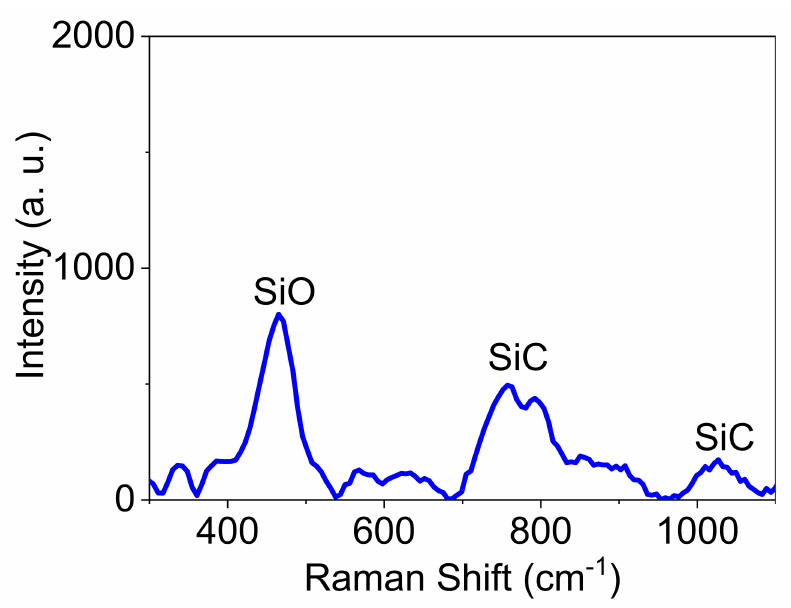
Figure 3. Raman spectrum of Pd@C–PS. The X-ray diffraction (XRD) pattern of Pd@C–PS was prepared to determine diffrac- tion peaks corresponding to Si and Pd. The peak of PS at 2 θ = ~22.45 and peaks of Pd corresponding to (111), (200), and (220) verified the support structure and Pd doping (Figure 4) [39].